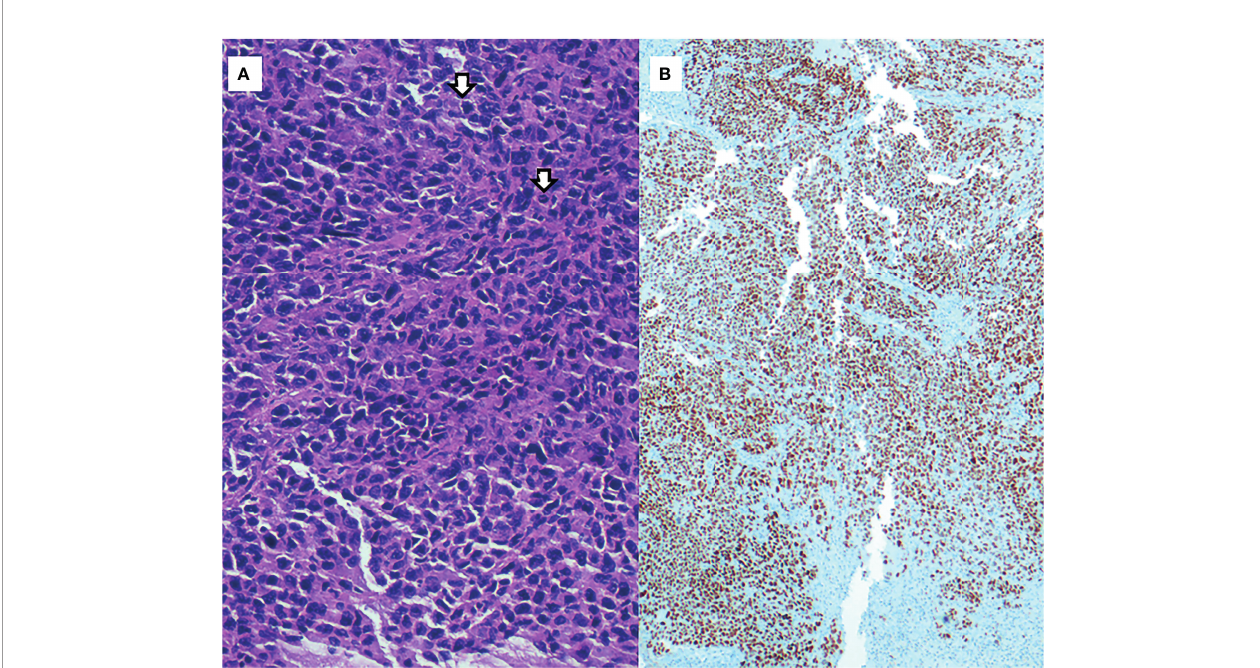
FIGURE 2 | (A) H&E, 400x: High-grade adenocarcinoma, with a solid growth pattern and mitotic fi gures (arrows). (B) Immunohistochemical staining of TTF-1 (200x): strong and diffuse nuclear positivity of neoplastic cells.